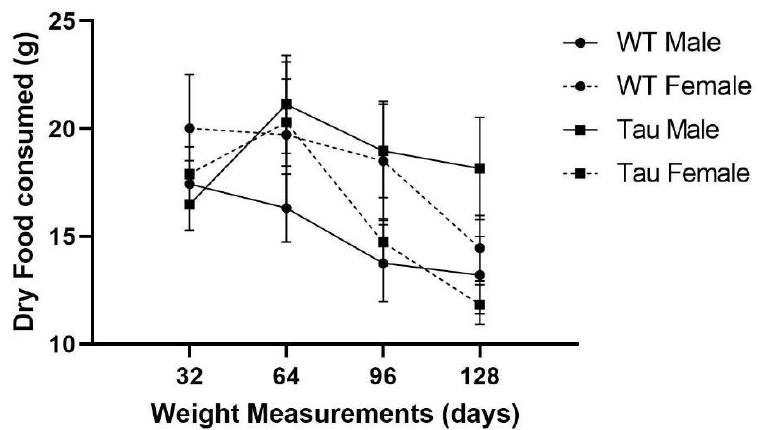
Figure 3. Dry food consumption over time. As the experiment progressed, mice ate less dry food, p < 0.01. Male tau mice consumed significantly more dry food than male WT mice ( p < 0.05). Error bars represent mean ± SEM.